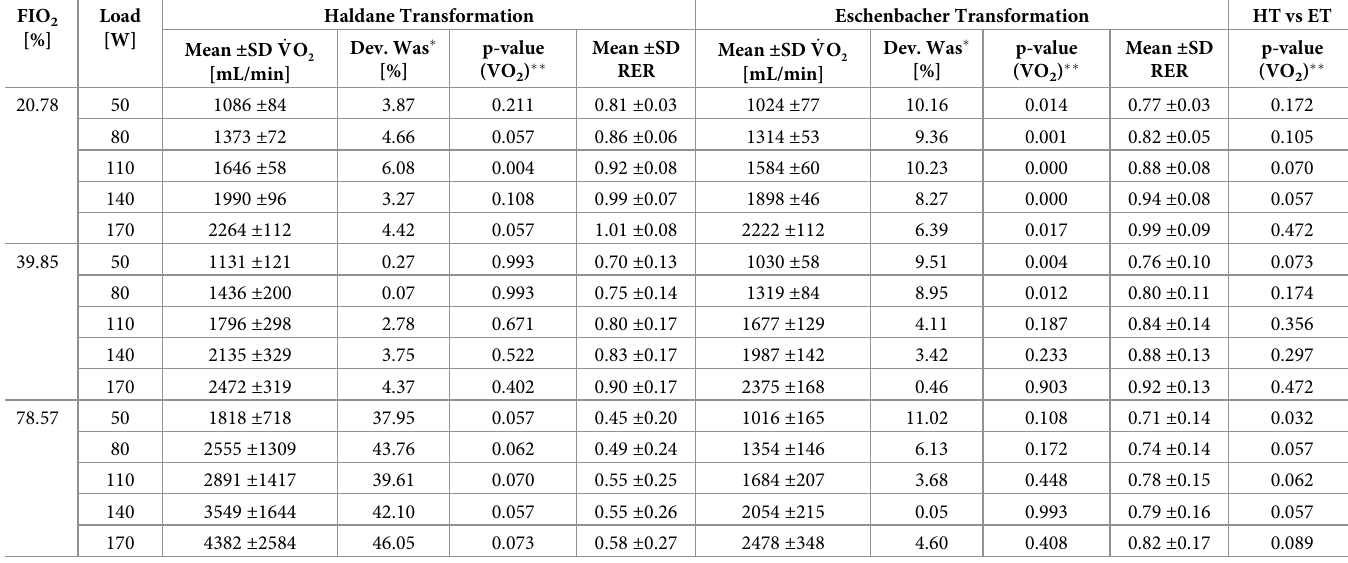
Table 3. Mean (SD) _ VO , %Deviation from the Wasserman formula, t-test ( _ VO 2